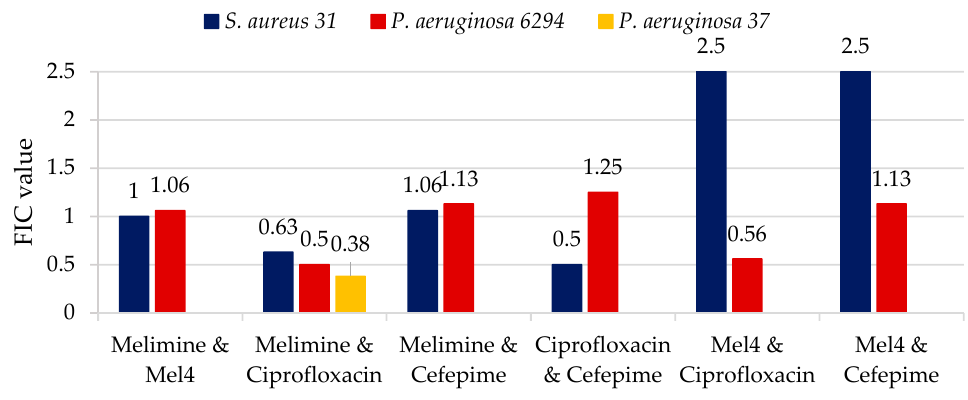
Figure 1. Fractional inhibitory concentrations of the combination of antimicrobial peptides (AMPs) and antibiotics.